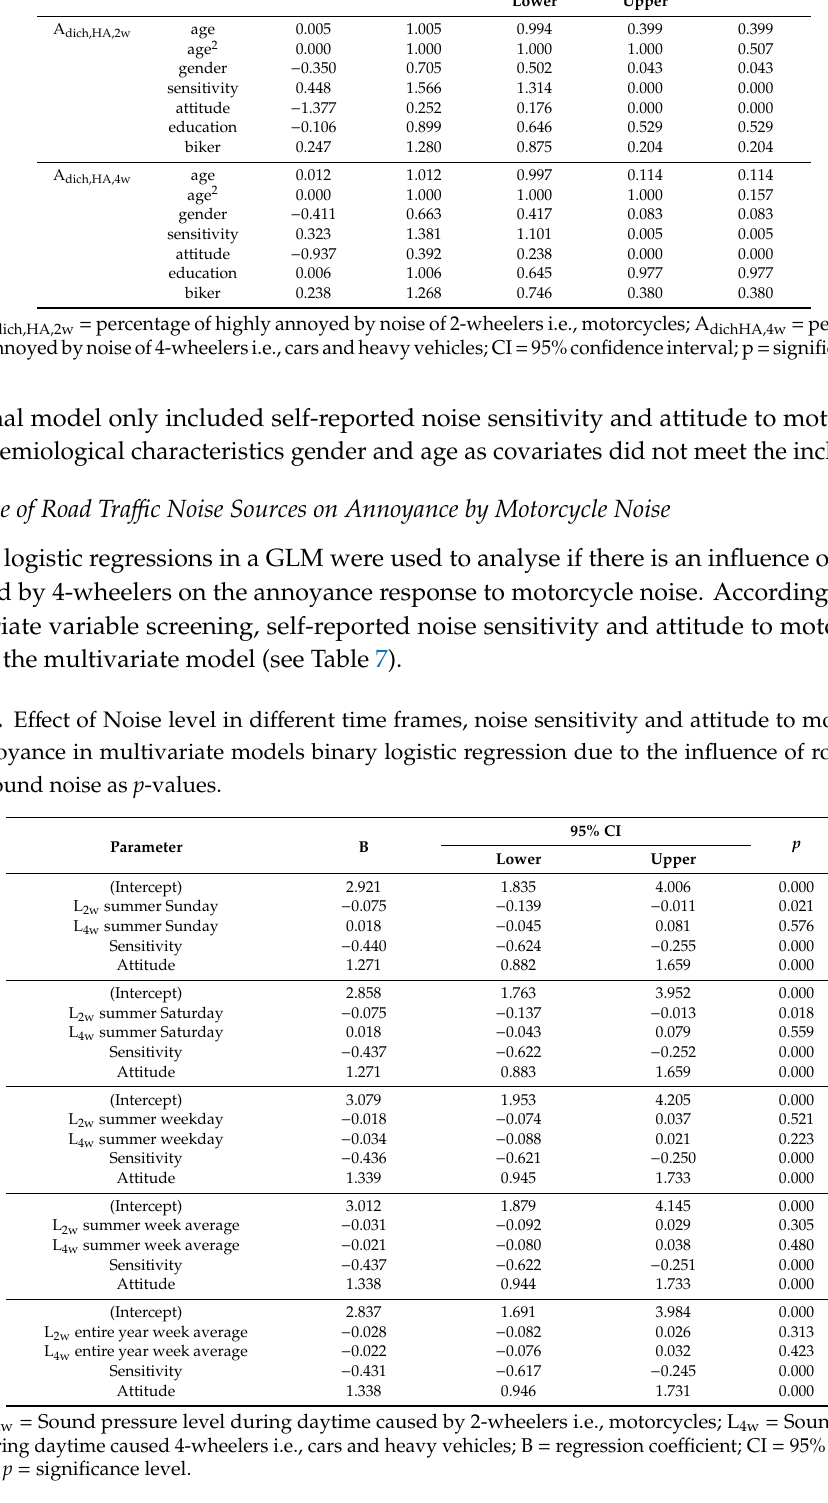
95% CI p Regr. Coe ff . Odds Ratio Lower